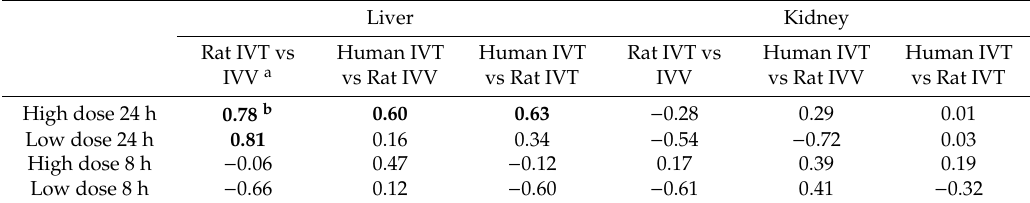
Table 4. Pearson correlation coe ffi cients between injury modules activated by exposure to thioacetamide or its metabolite in human in vitro studies and those activated in rat in vitro and in vivo studies. Liver